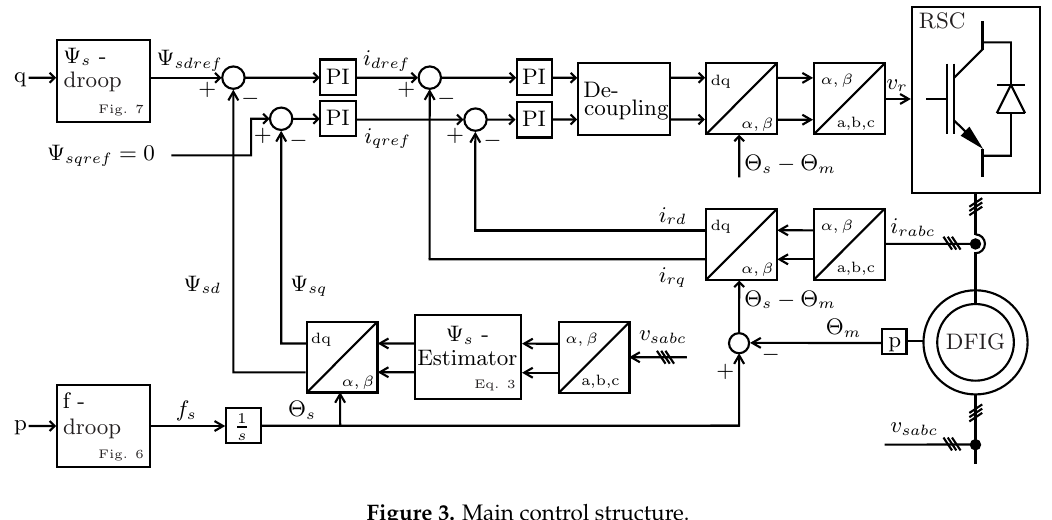
Figure 3. Main control structure.